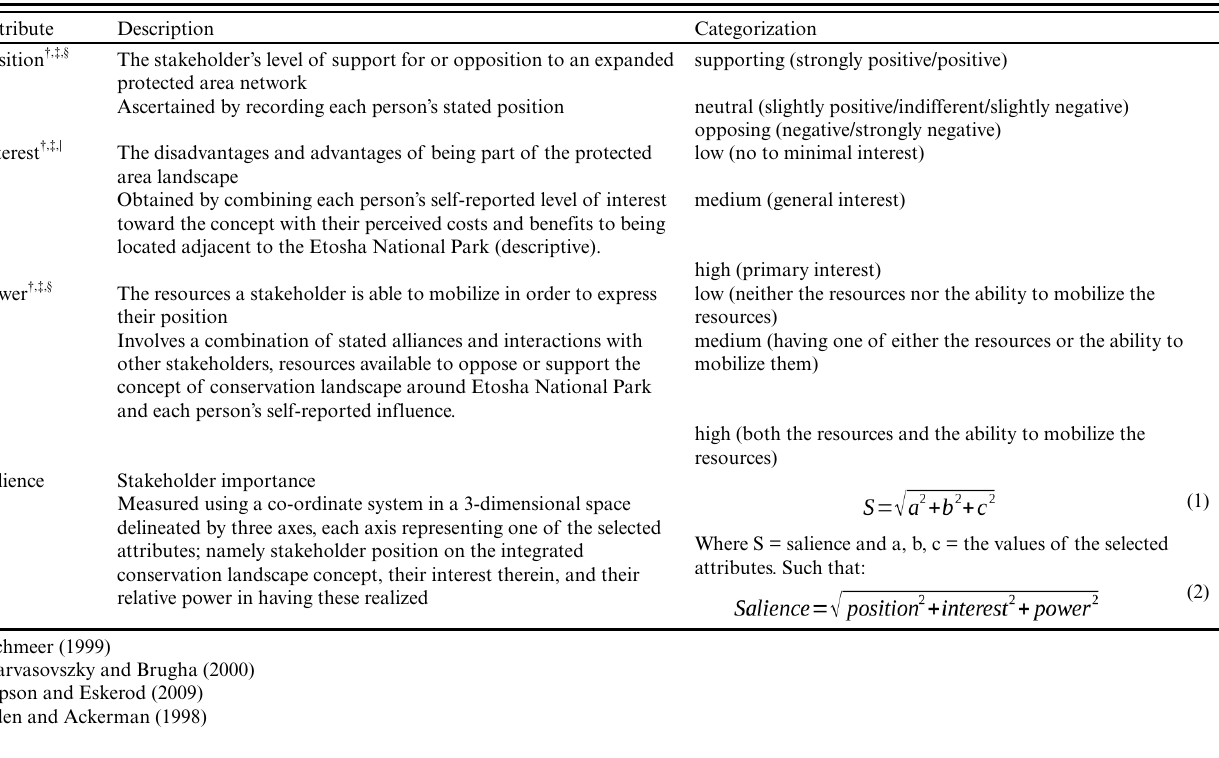
Table 2 . Description of stakeholder attributes used to categorize stakeholders.